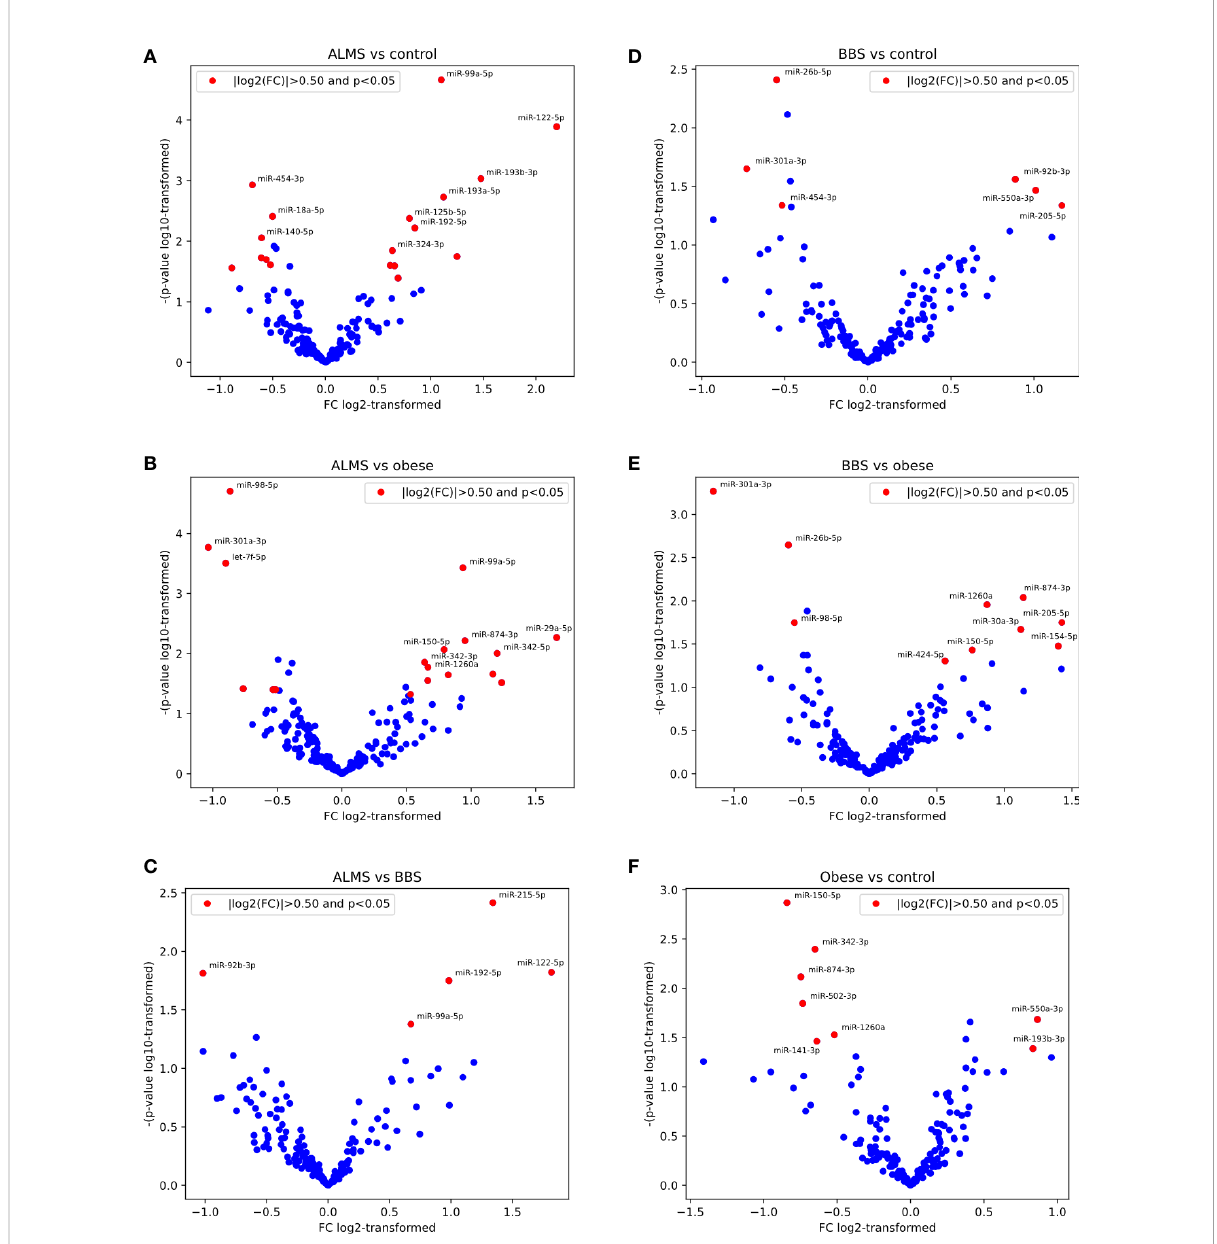
FIGURE 2 Pairwise results of differential expression analysis for following comparisons: ALMS vs controls (A) , obese (B) and BBS (C) , BBS vs controls (D) and obese (E) , and obese vs controls (F)